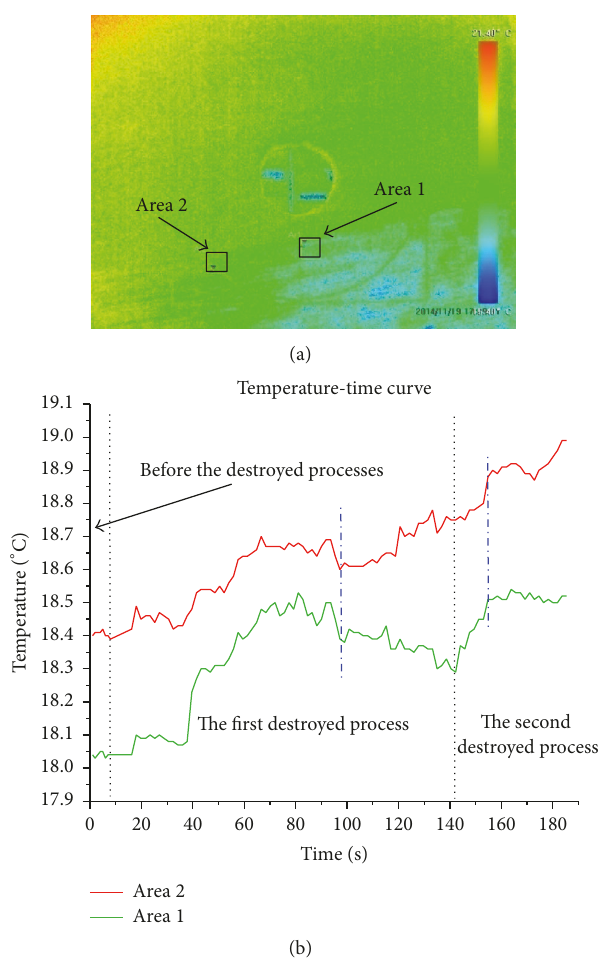
Figure 9: Diagrams of the arrangement of the temperature ROIs and temperature variation curves; (a) diagram of the arrangement of the temperature ROIs on the infrared image before the destroyed processes; (b) diagram of temperature variation curves of the ROIs in destroyed